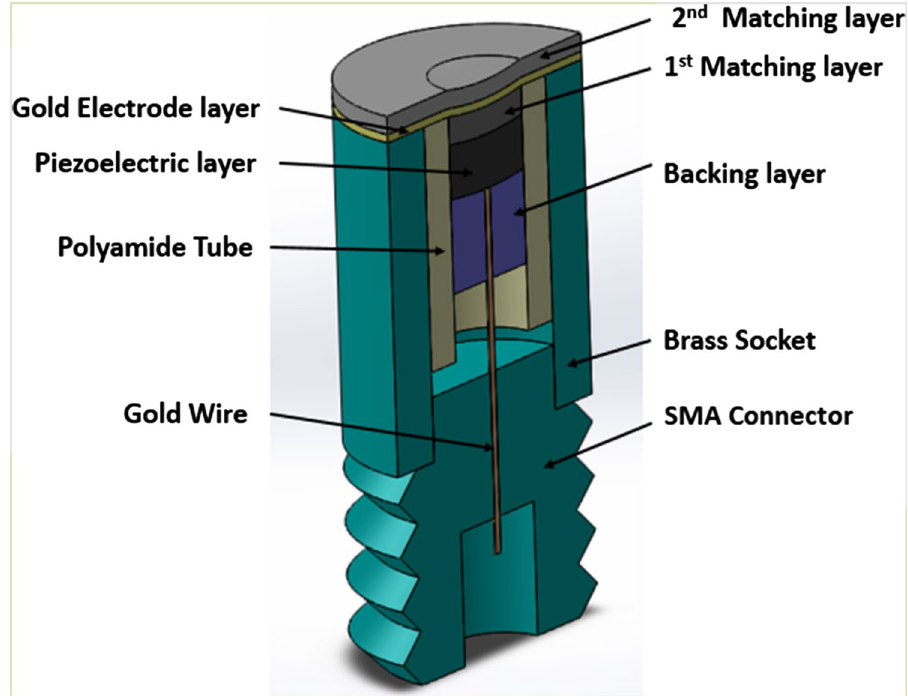
Fig. 1 Schematics of a single element HF US probe